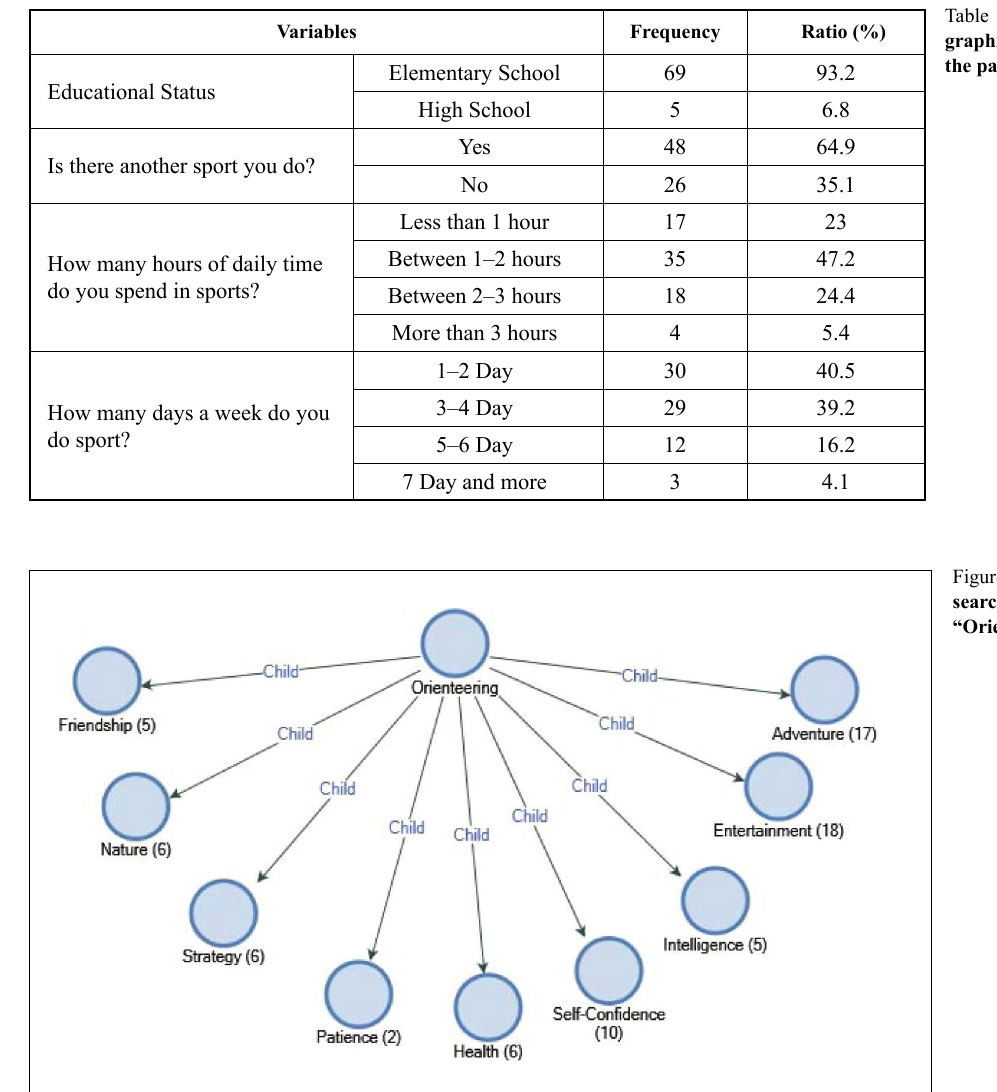
Table 2. Some socio-demo- graphic information about the participants